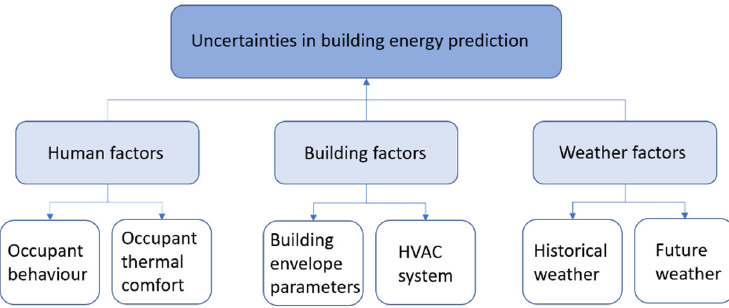
Figure 4. Three sources of building energy prediction uncertainty. Table 9. The effects of human factors, building factors, and weather factors on the three prediction model